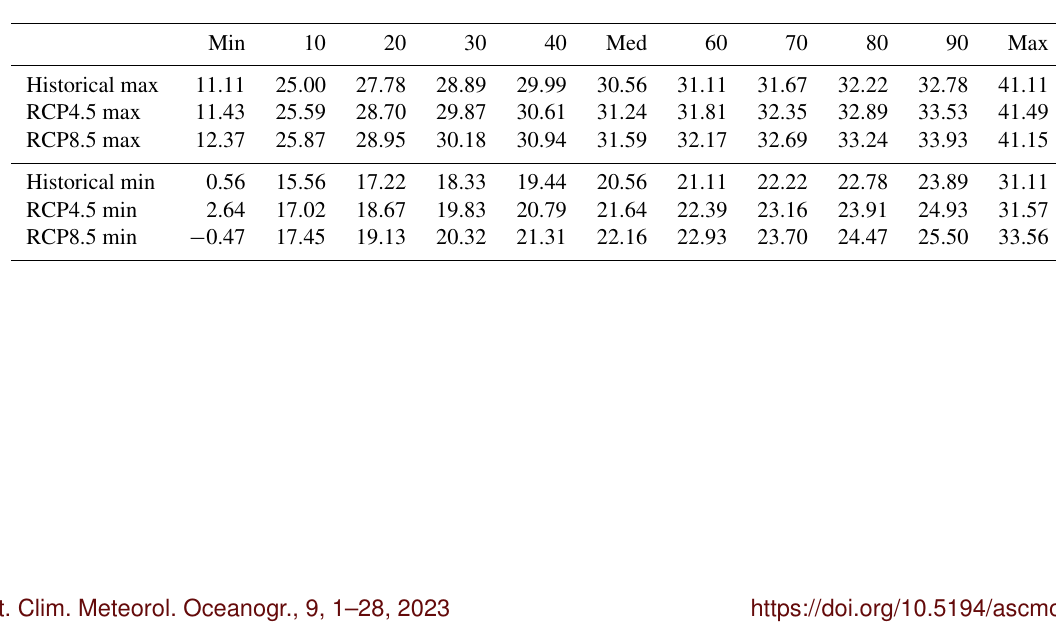
Table C1. Maximum daily temperature quantiles ( ◦ C, top panel) and minimum daily temperature quantiles ( ◦ C, bottom panel) for the ob- served historical GHCN climate, the downscaled RCP4.5 climate, and the downscaled RCP8.5 climate using the Hadley Centre’s HadGEM2-